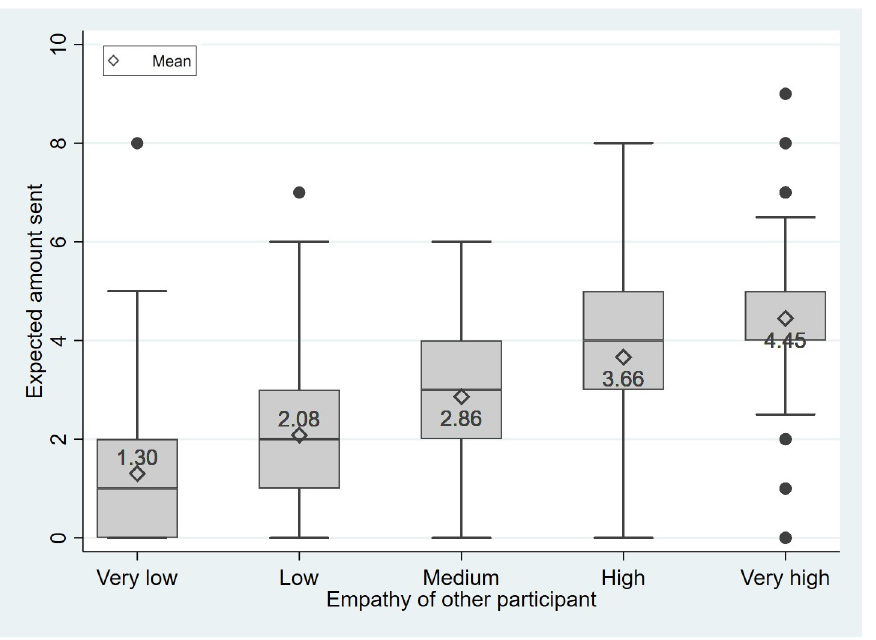
Fig 3. Boxplot of expected prosocial behavior conditional on the empathy of the other